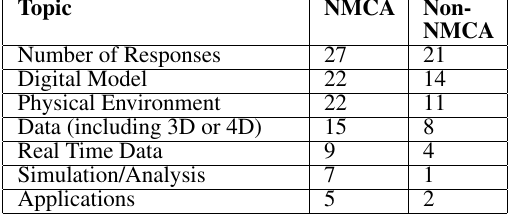
Table 3: Defining a Digital Twin